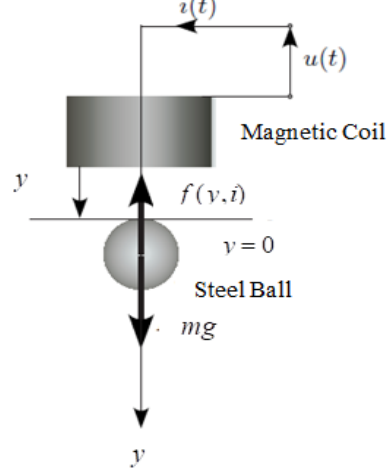
Figure 1: Magnetic Suspension